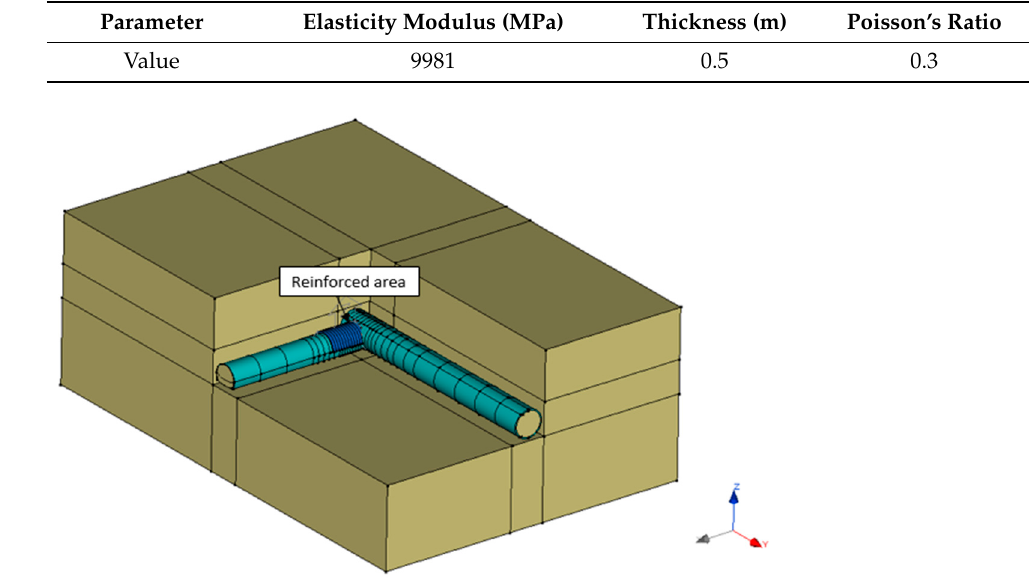
Figure 4. Geometry adopted for the improved region above the cross passage.